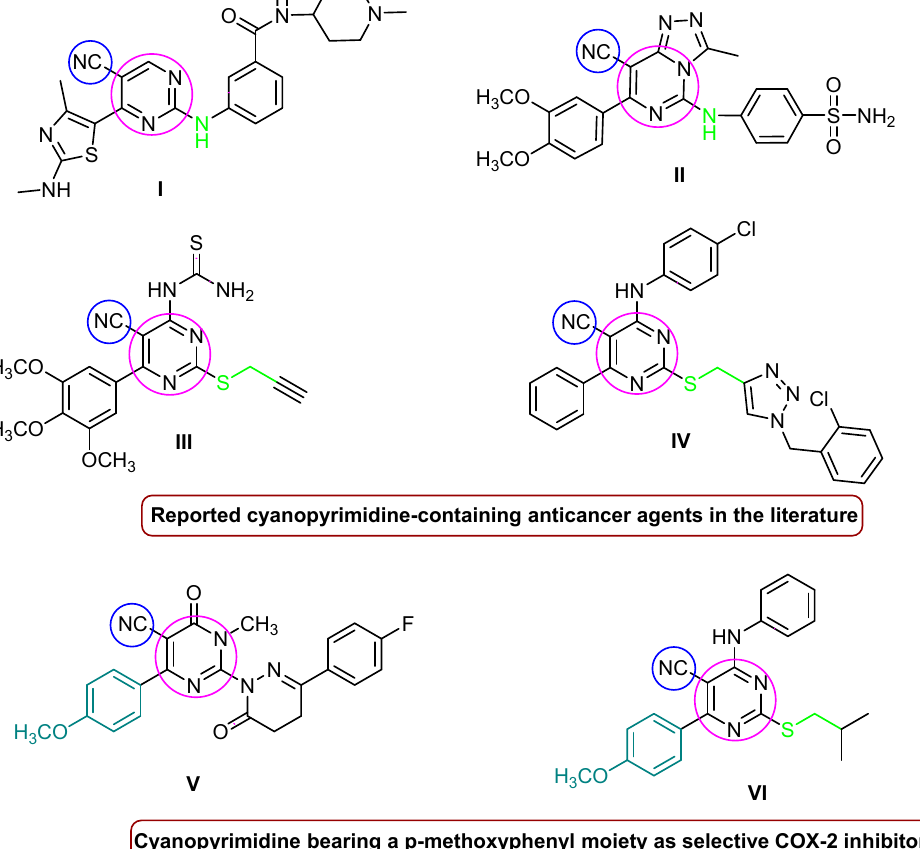
Figure 1. Anticancer agents and selective COX-2 inhibitors containing pyrimidine nucleus and cyano groups. The benzenesulfonamide moiety constitutes an essential feature for selective COX-2 inhibitors [29] as well as the commercial COX-2 inhibitors drugs, such as celecoxib, apri- coxib, and parecoxib. Additionally, compound VII (Figure 2), which contains a pyrimi- dine-based sulfonamide phenyl pharmacophore, outperformed rofecoxib (IC 50 = 292 nM) by 780-fold (IC 50 = 12.7 nM) in COX-2 inhibitor potency [30]. Furthermore, a N-(2,6- dimethoxypyrimidin-4-yl) benzenesulfonamide derivative VIII (Figure 2) inhibited COX-2, with IC 50 values in the range of 0.22-0.67 µM, which was higher than Celecoxib (IC 50 = 7.70 µM). Such compounds have demonstrated promising anticancer activity against a variety of cell lines, indicating a connection between selective anti-COX-2 ef- fects and their anti-cancer activity [31]. In addition, benzoazoles (purine analogs in gen- eral) constitute a significant pharmacophore in both anticancer agents and COX-2 inhibi- tors; for example, rutecarpine, which has an indole moiety, is a potent COX-2 inhibitor with no adverse effects on the cardiovascular system. Further, benzoxazole and/or ben- zimidazole hybrid structures with a pyrimidine scaffold, such as compound IX (Figure 2), were found to significantly inhibit COX-2 enzymes. These synthesized derivatives showed activity against breast carcinoma (MCF-7) (IC 50 = 5.4 to 7.2 µM ) and non-small-